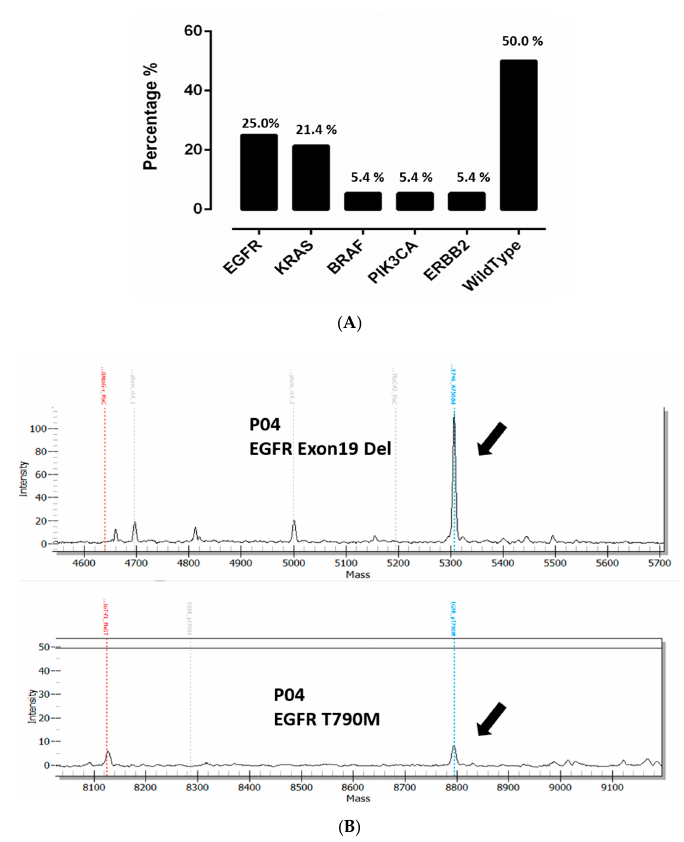
Figure 1. ( A ) Distribution of mutations detected in NSCLC ( n = 56) patients cfDNA. ( B ) Two MassARRAY plots from patient P04 showing an EGFR exon19 deletion and a p.T790M resistance causing mutation.